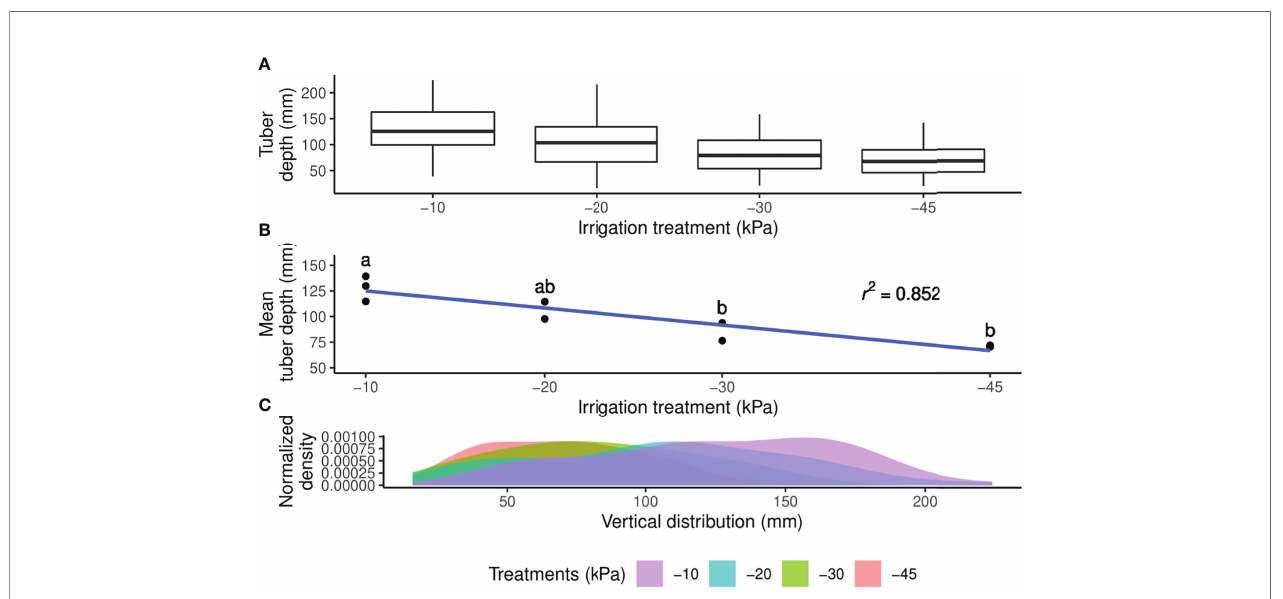
FIGURE 2 | (A) Tuber vertical distribution in mm for each irrigation treatment. (B) Mean tuber depth in each unit (indicated by points) for each irrigation treatment. Values with the different letters are signi fi cantly different (p < 0.05) according to the Tukey test. The blue line represents the linear regression across all the treatments. (C) Vertical distribution of tuber density grouped according to irrigation